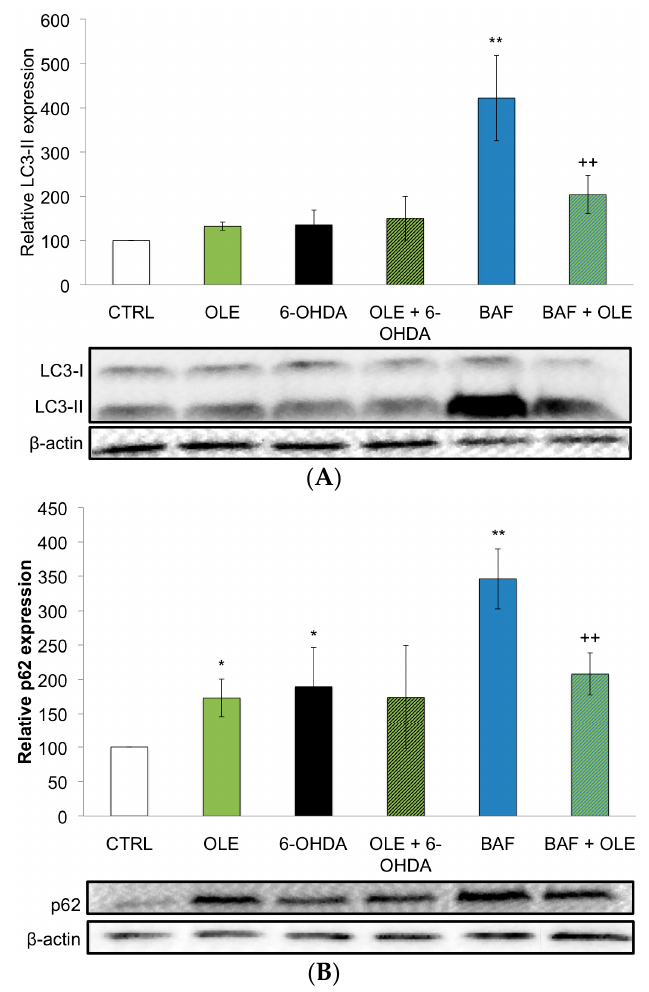
Figure 5. OLE regulates LC3-II and p62 protein expression. ( A ) Western blotting analyses demonstrate that a treatment with 10 -12 M OLE alone does not significantly increase LC3-II protein expression compared to CTRL. Treatment of neuronal PC12 cells for 1 h with 100 nM bafilomycin A1 (BAF), an inhibitor of autophagic vesicle clearance, dramatically increases LC3-II protein expression. Pre-treatment with OLE prior to BAF administration reduces the amount of LC3-II. Data are expressed as means ± SEM, n = 3. ** p ˂ 0.01 compared to CTRL and ++ p ˂ 0.01 compared to BAF; ( B ) Contrarily to LC3-II, p62 expression is significantly increased by OLE alone. Treatment with BAF strongly increases p62 expression while a pre-treatment with OLE partially rescues p62 levels. β actin served as internal control. Data are expressed as means ± SEM, n = 3. ** p ˂ 0.01 compared to CTRL, * p ˂ 0.05 compared to CTRL and ++ p ˂ 0.01 compared to BAF.